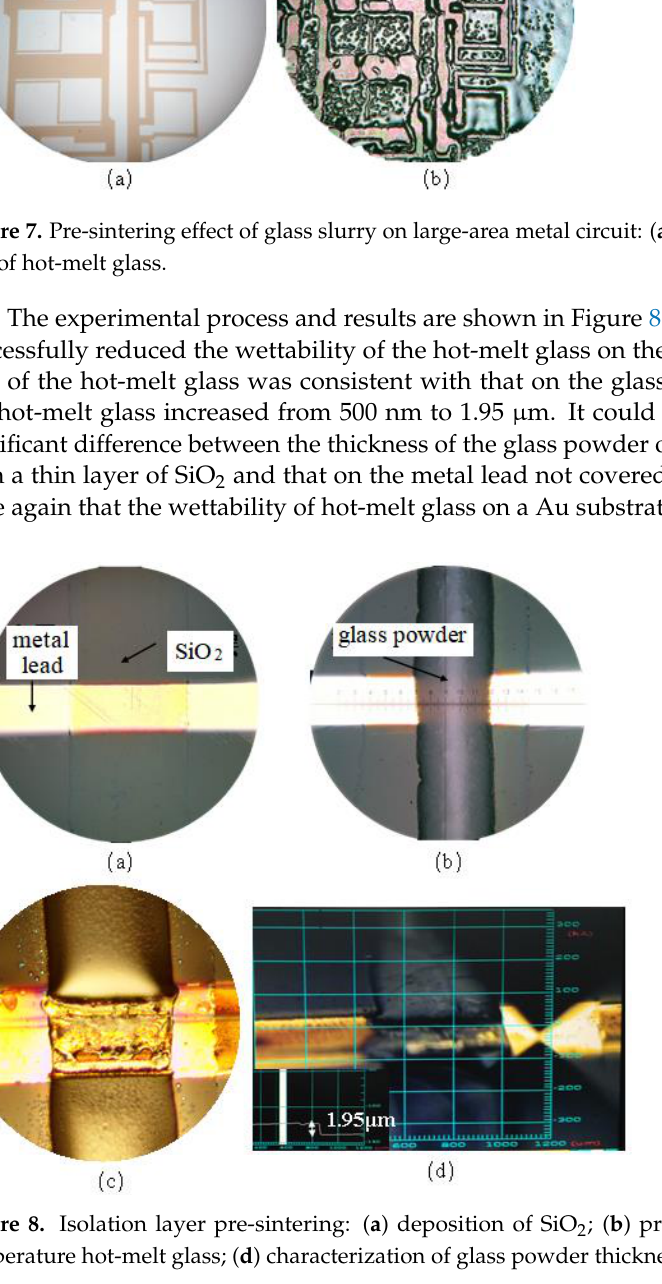
Figure 6. Sintering effect of hot-melt glass: ( a ) slurry morphology; ( b ) measuring diagram of step meter.